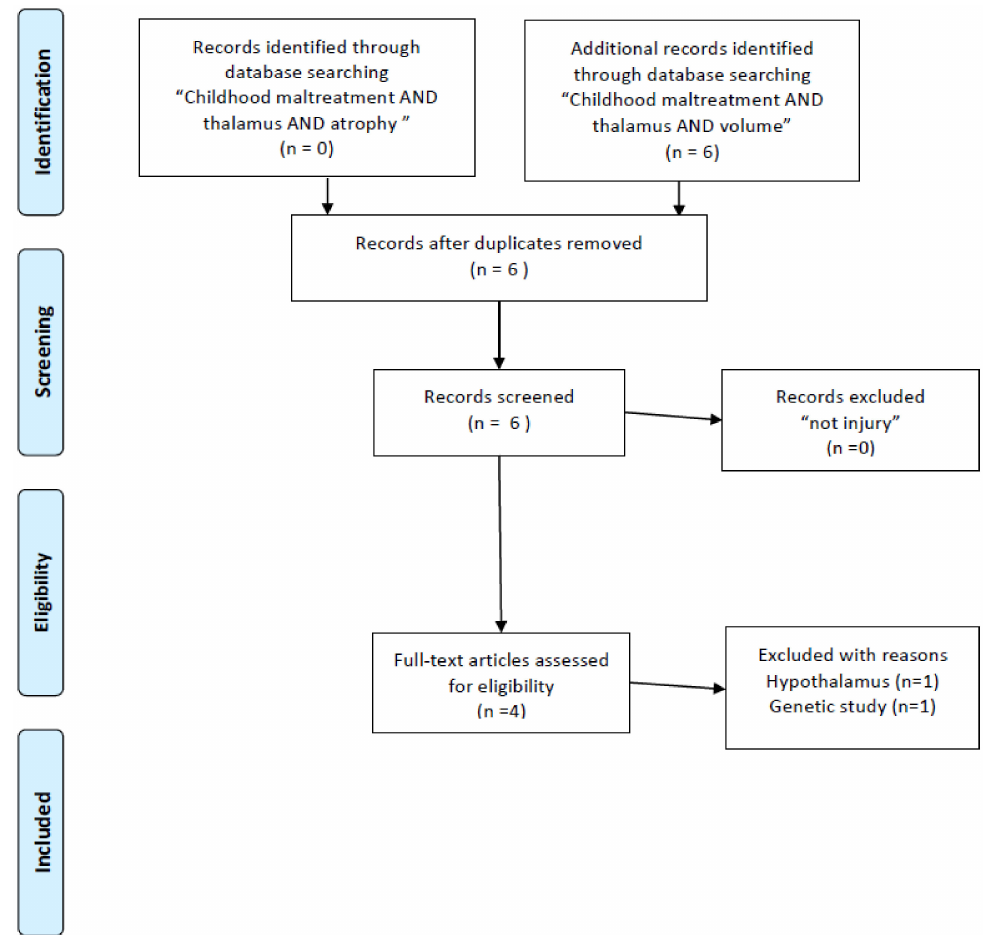
Figure 2. PRISMA flow diagrams [25] of literature research for brain structure research of childhood maltreatment targeting on the